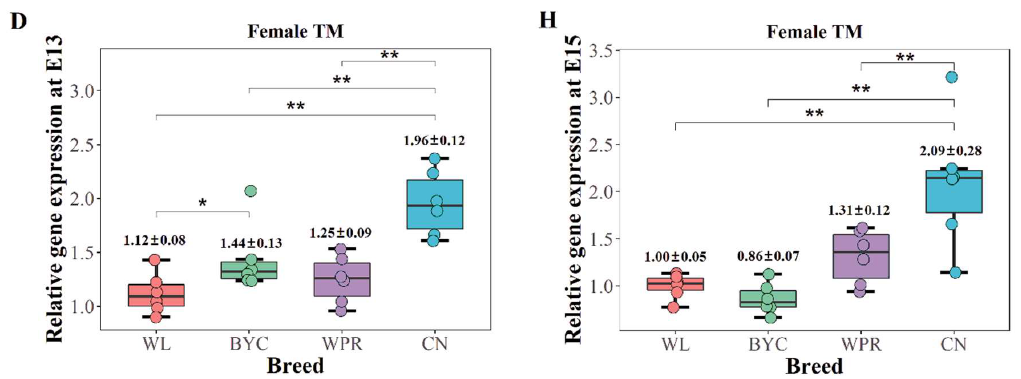
Figure 2. Gene expression of Myomaker among the various chicken breeds. ( A – D ) Myomaker gene expression differences among the four chicken breeds in the pectoral muscle of males (PMM), the thigh muscle of males (TMM), the pectoral muscle of females (PMF), and the thigh muscle of females (TMF) at E13. ( E – H ) Myomaker gene expression differences among the four chicken breeds in the PMM, TMM, PMF, and TMF at E15. **, *, and ns represent adjusted p values of <0.01, <0.05, and >0.05, respectively.